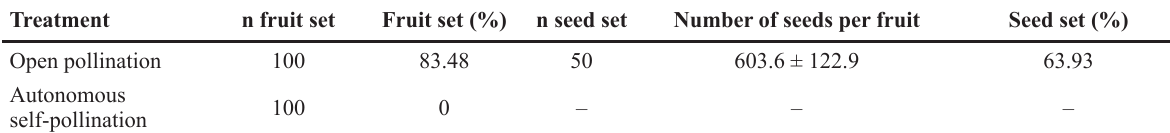
Table 5 – Reproductive success after different pollination treatments in Campanula vardariana